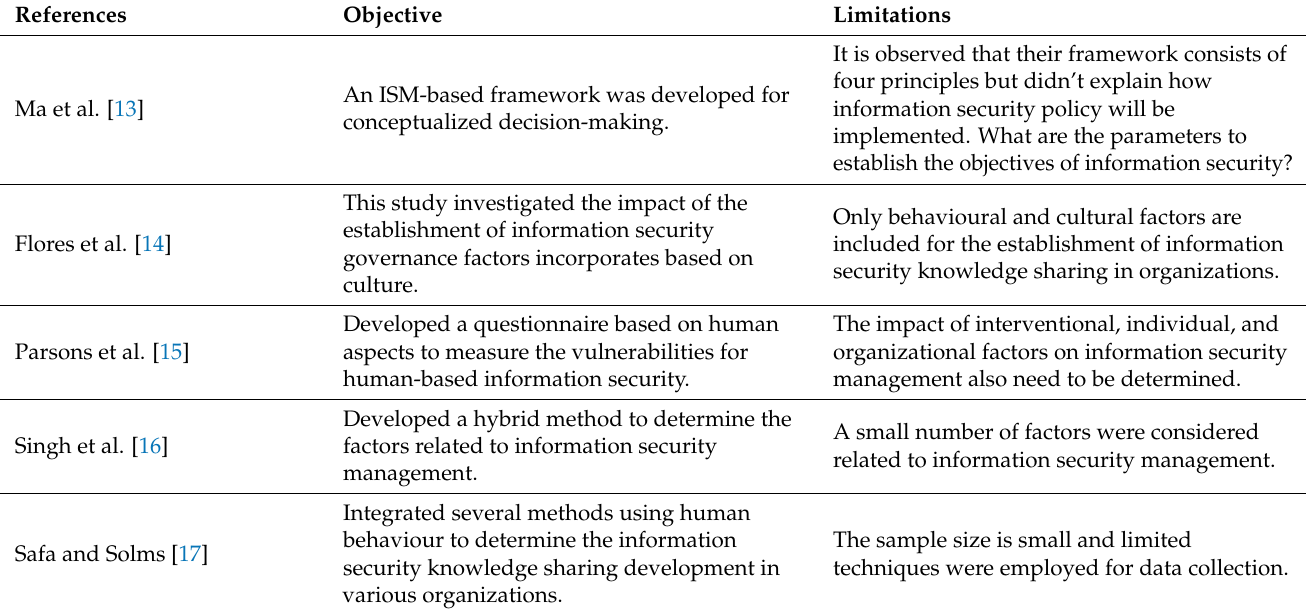
Table 1. Relevant studies in the field of information security